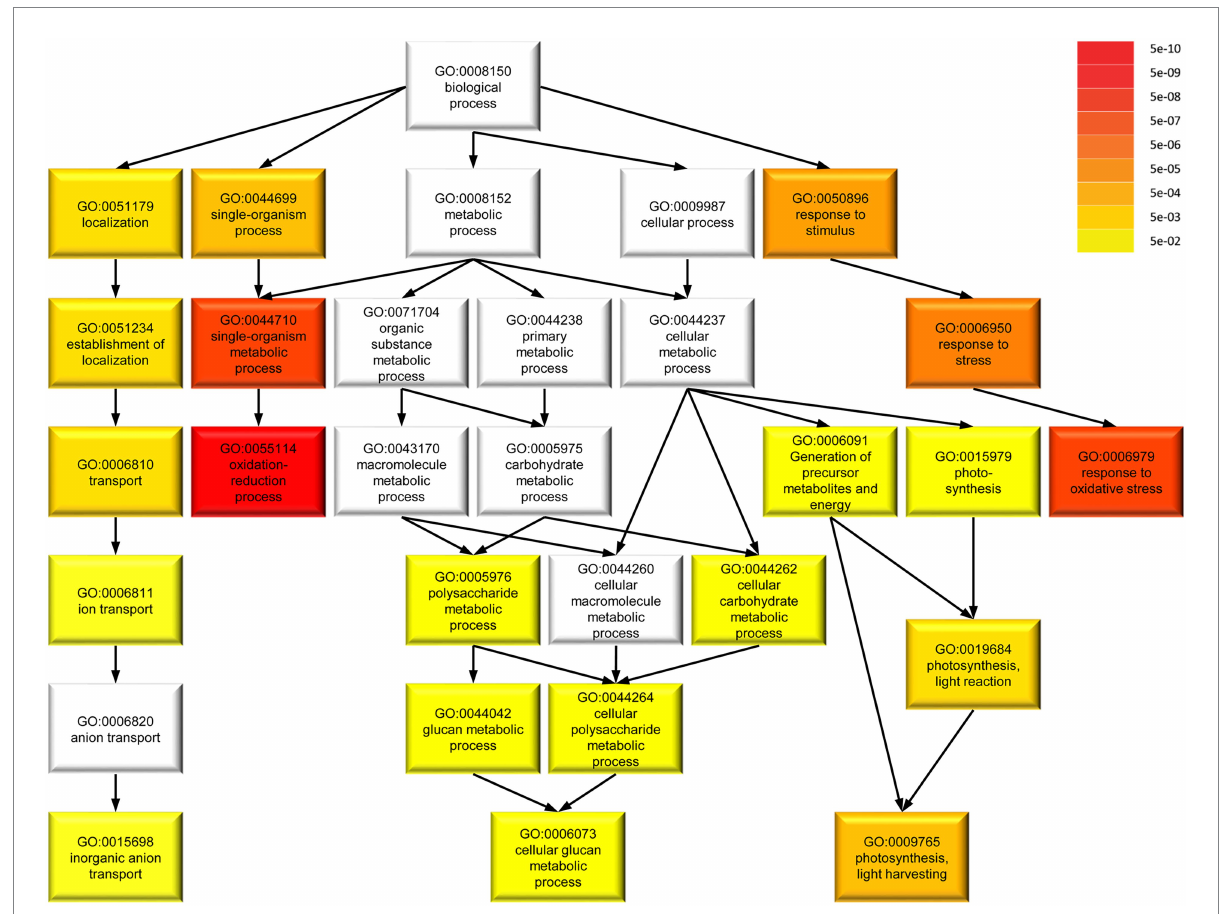
FIGURE 8 Gene ontology (GO) term enrichment of 217 DEGs in Mp spirrig with annotated terms in M. polymorpha. Darker colors in GO term categories represent higher enrichment indicated by lower false discovery rate (FDR). The analysis was performed with agriGO v2.0 on the background of the M. polymorpha locus ID v3.1 (Phytozome